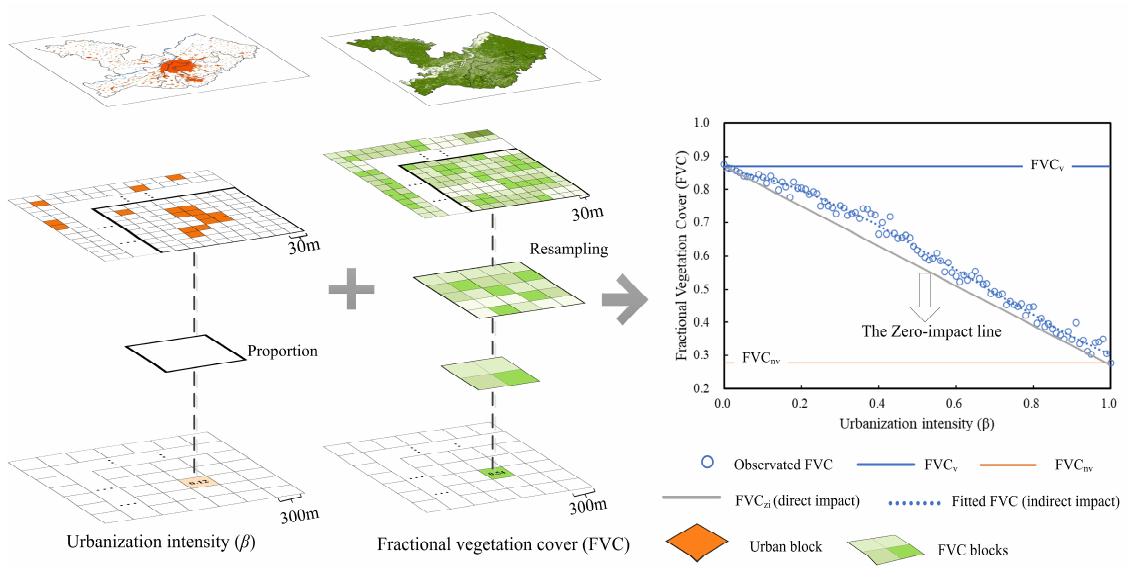
Figure 2. The theoretical diagram for quantifying the direct and indirect impacts of urbanization on vegetation growth based on urban intensity ( β ) and FVC. The gradient of urbanization’s change along the FVC assuming direct impact (FVC zi , the zero-impact line) is shown by a grey line. The blue circles and dash line are observed FVC, and cubic regression of the average FVC. The work of Zhao et al. [23] is the basis for the computational framework depicted in this figure.